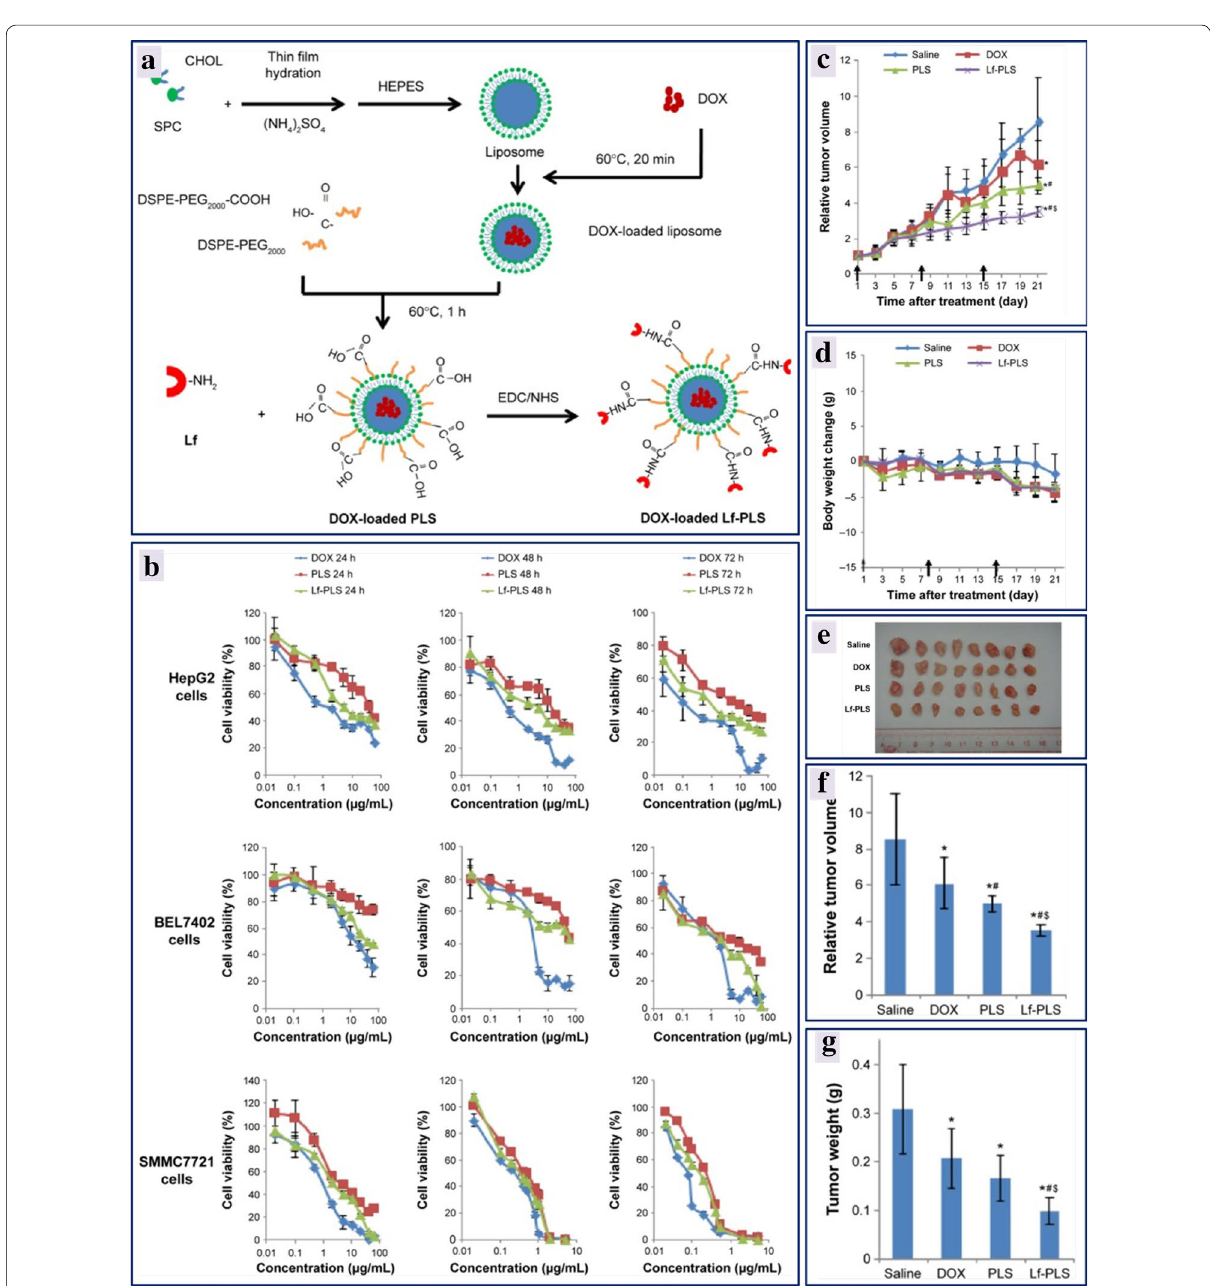
Fig. 7 Scheme representing the formulation of doxorubicin loaded PEGylated liposome, and doxorubicin loaded lactoferrin modified PEGylated liposome ( a ); effect of cell viability of free DOX and the liposomal formulations evaluated by MTT assay in HepG2, BEL7402, and SMMC7721 cells at different time intervals ( b ); relative tumor volume of various liposomal formulations injected to tumor-bearing mice through tail veins every 7 days at a dose of 5 mg/kg DOX ( c ); change in the body weight of tumor-bearing mice after each treatment ( d ); image of tumors excised on 21st day from each treatment group ( e ); relative tumor volume at the time of sacrifice from each treatment group ( f ); tumor weight at the time of sacrifice from each treatment group ( g ) (reproduced with permission from